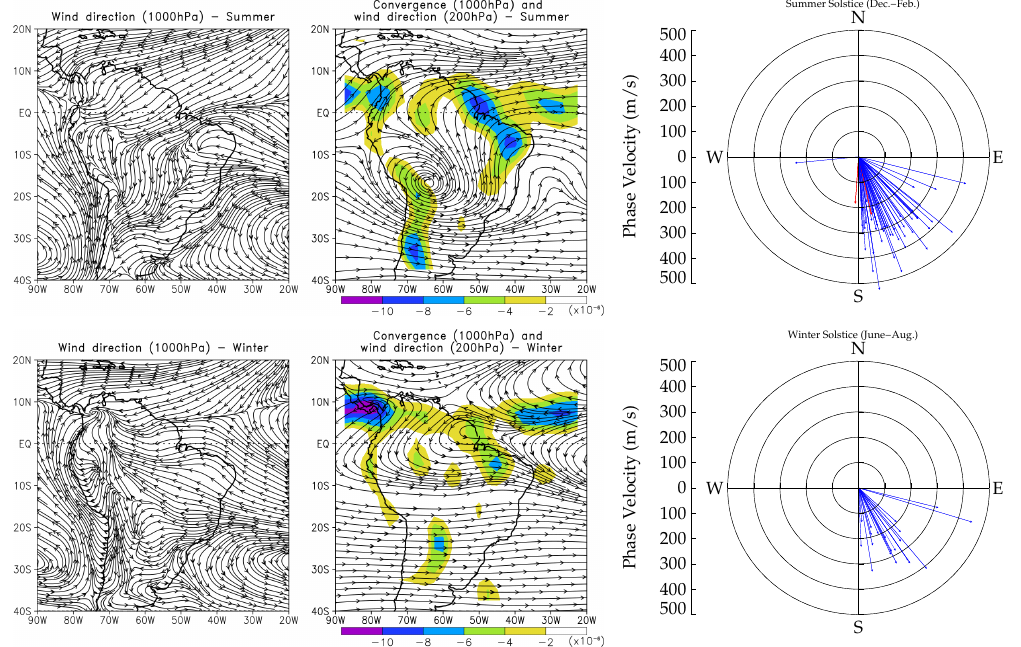
Figure 8. Seasonal average position of the ITCZ (first two columns) and propagation direction of the observed MSTIDs (third